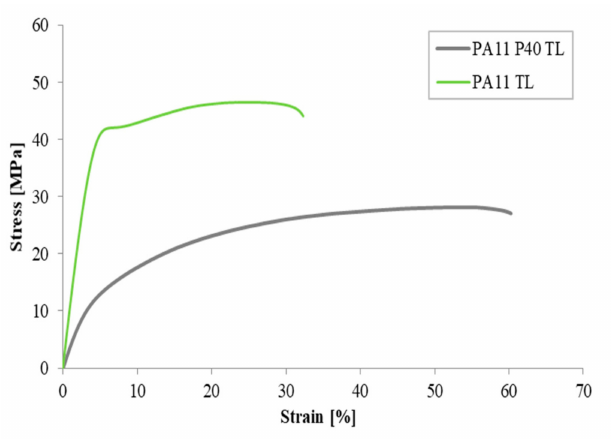
Figure 3. Representative tensile stress-strain curves of PA11